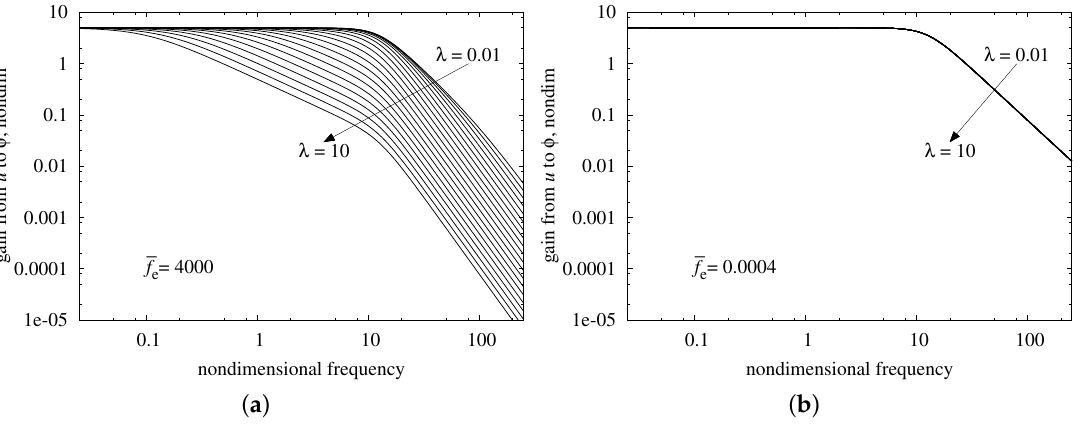
Figure 4. Frequency response of transconductance and transpermeance amplifiers under λ variation. ( a ) Gain from command voltage to flux: transconductance ( ¯ f e = 4000) ; ( b ) gain from command voltage to flux: transpermeance ( ¯ f e =